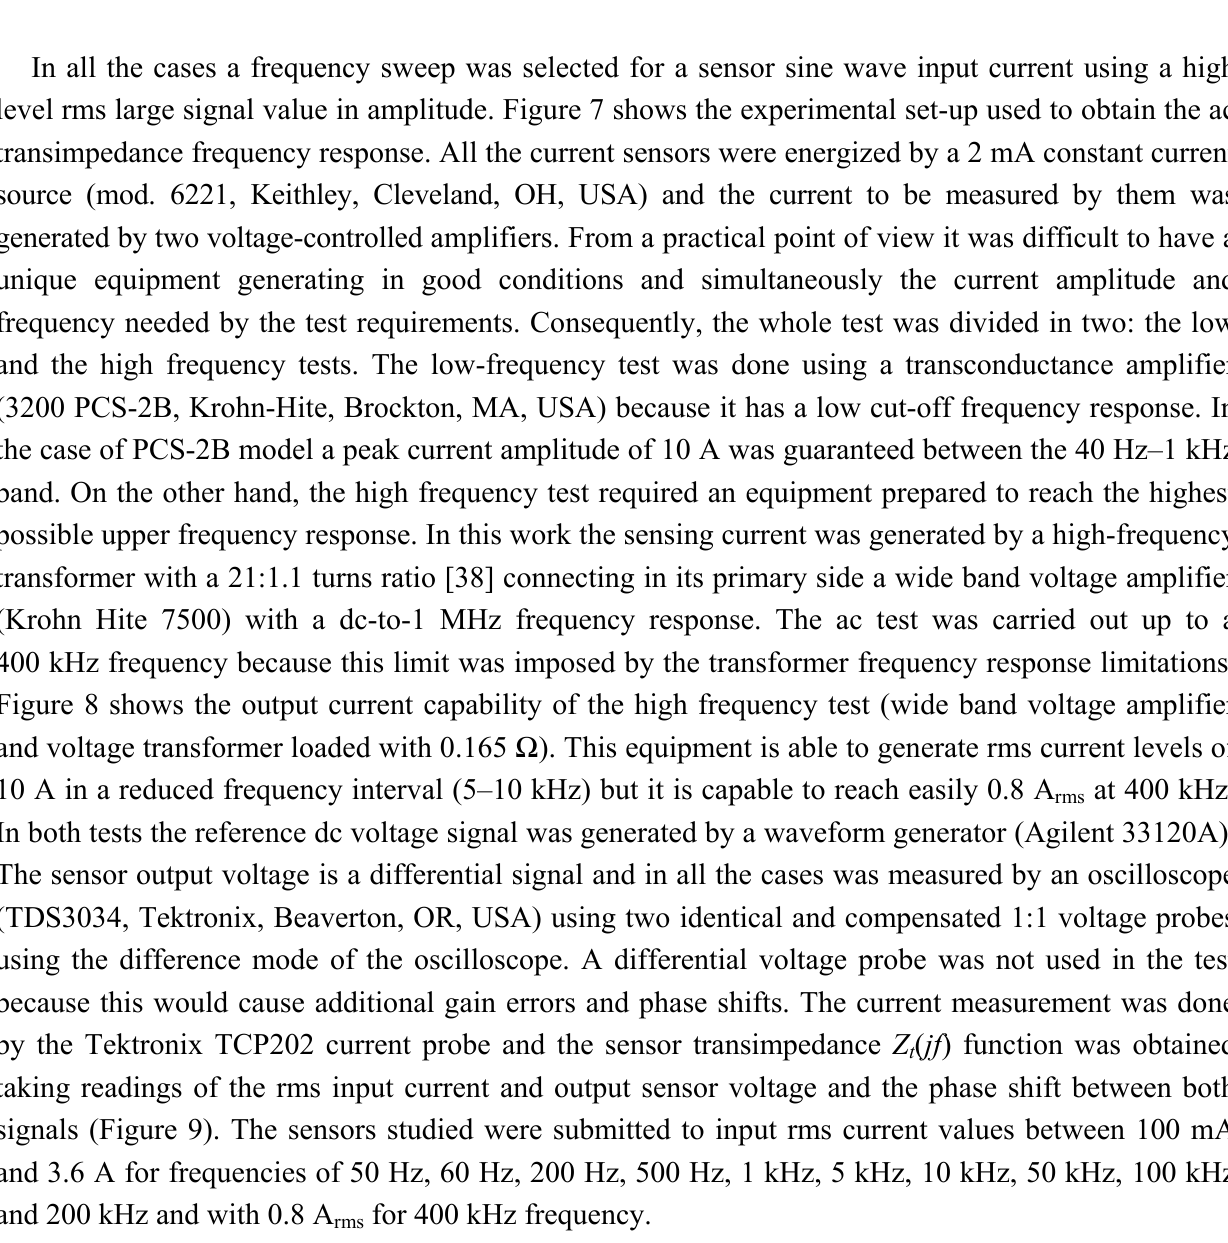
Figure 7. Experimental set-up to test the sensors transimpedance AC large-signal frequency